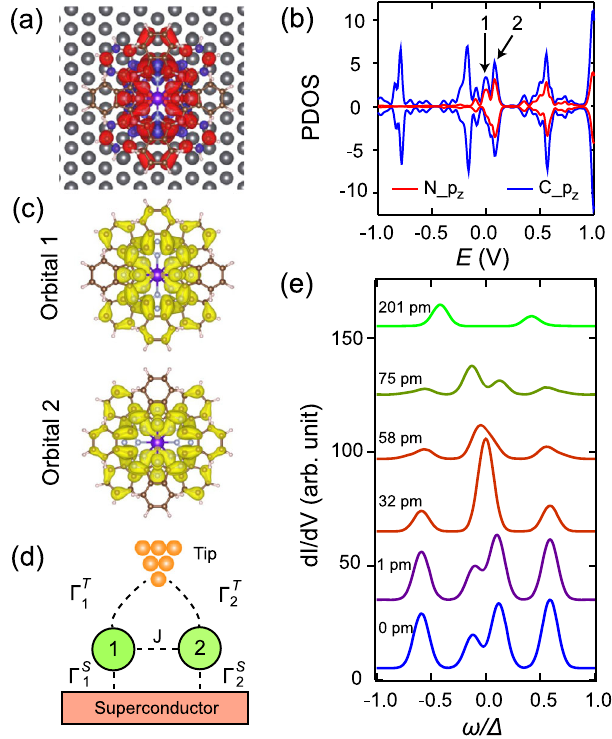
Fig. 4 | Theoretical calculations. a DFT calculated spatial distribution of mag- netic moment in Tb 2 Pc 3 on Pb(111) (gray balls). The red (blue) color represents spin-up (spin-down) electron density. b PDOS of Tb 2 Pc 3 on Pb(111) projected on p z orbital of C and N atoms. Orbital 1 and orbital 2 are split due to adsorption on Pb(111). c Charge distribution of the two orbitals in isolated [Tb 2 Pc 3 ] − , which correspond to the orbitals marked with arrows in ( b ). d Schematics showing the theoretical model. The two orbitals 1 and 2 couple to each other with the exchange coupling J , while Γ T i ( Γ S i ) represents the hybridization between the orbital i =1, 2 and the tip (superconducting substrate). e Calculated variation of YSR states by reducing tip height δ Z